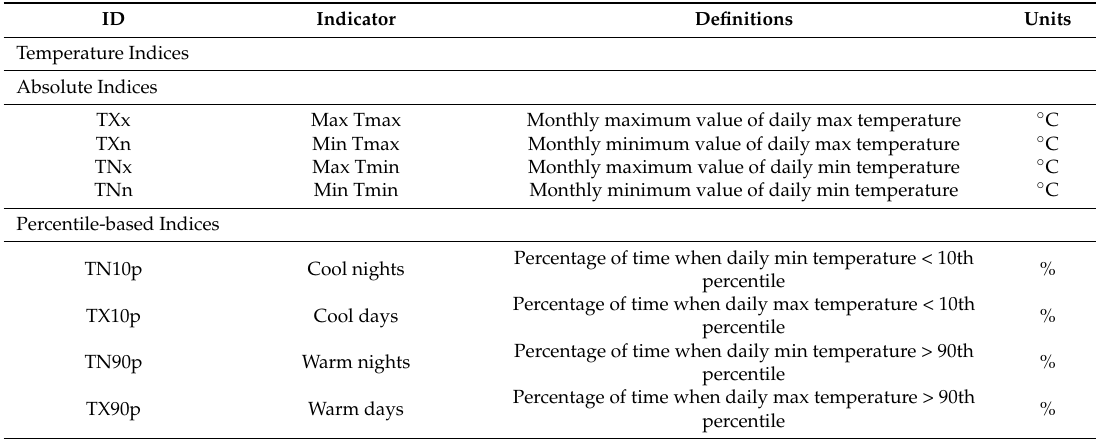
Table 2. Temperature and precipitation indices used in this